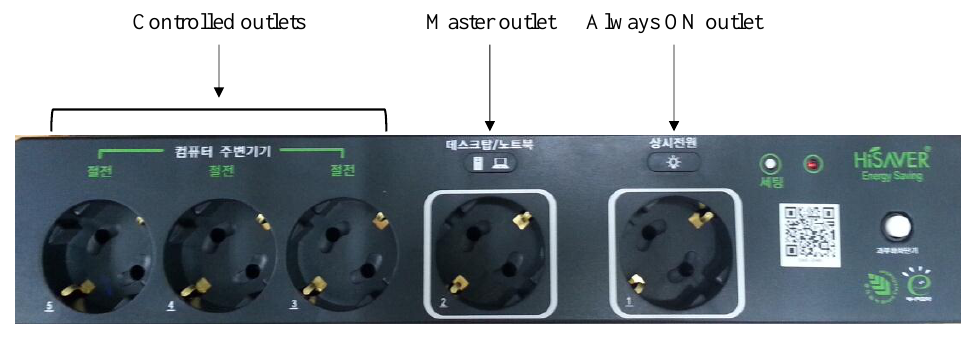
Figure 9. Cutoff device.